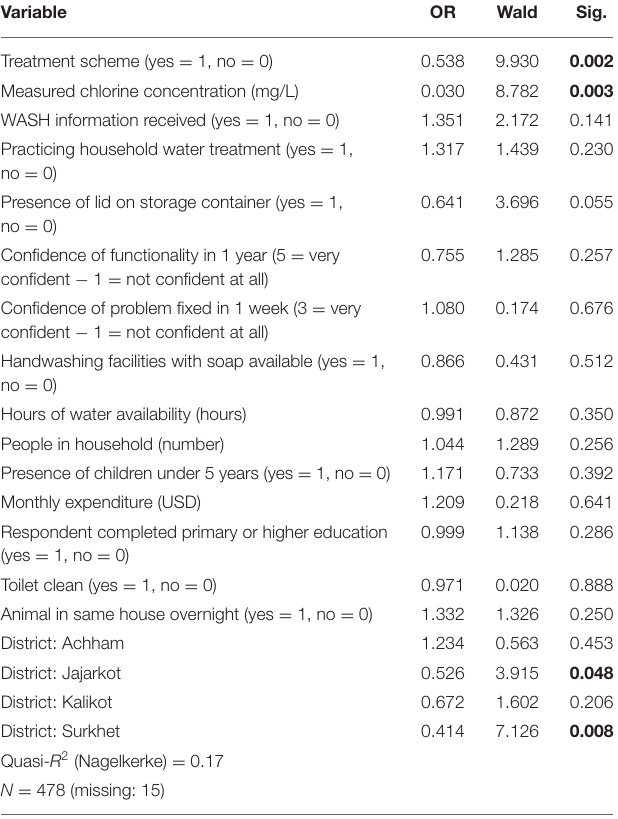
TABLE 5 | Ordinal logistic regression model of the factors explaining risk of fecal contamination of stored drinking water (0 for < 1 E. coli CFU/100mL, 1 for 1–10 E. coli CFU/100mL, 2 for 11–100 E. coli CFU/100mL, 3 for > 100 E. coli CFU/100mL) at endline, with the odds ratio (OR), Wald statistic, and the level of significance